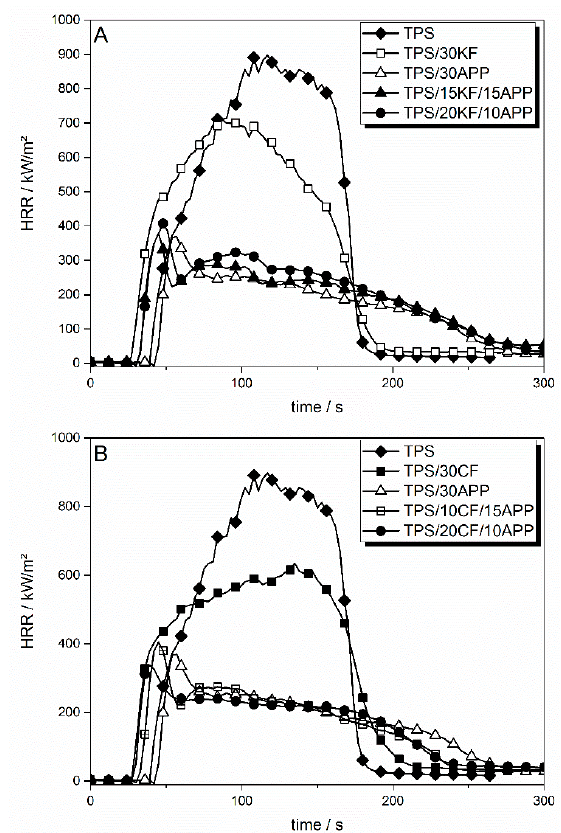
Figure 13. HRR curves for combinations of APP with keratin fibres ( A ) and coconut fibres ( B ).